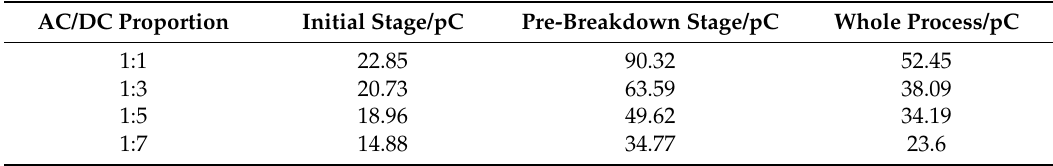
Table 4. Relationship between mean PD amplitude and AC/DC proportions.